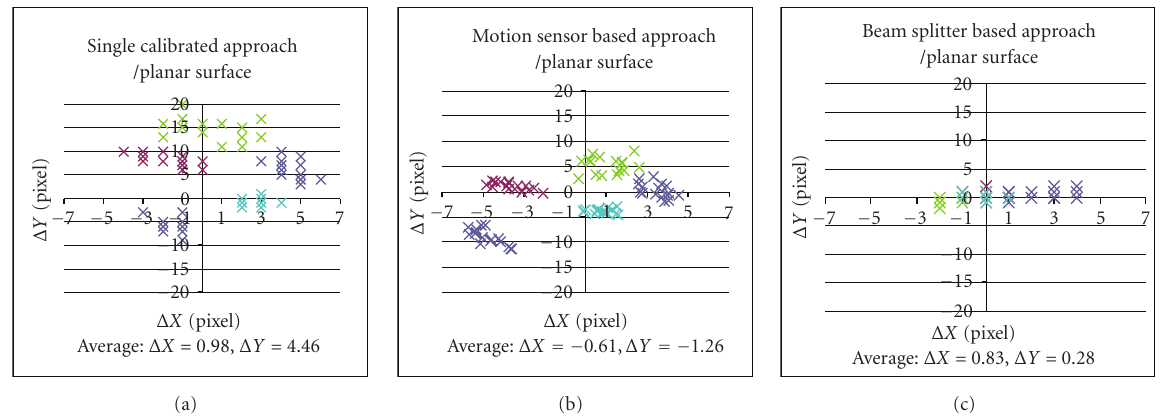
Figure 10: Geometric error (camera coordinates) of the single calibrated approach, the motion-sensor-based approach and the beam- splitter-based approach on planar surfaces.